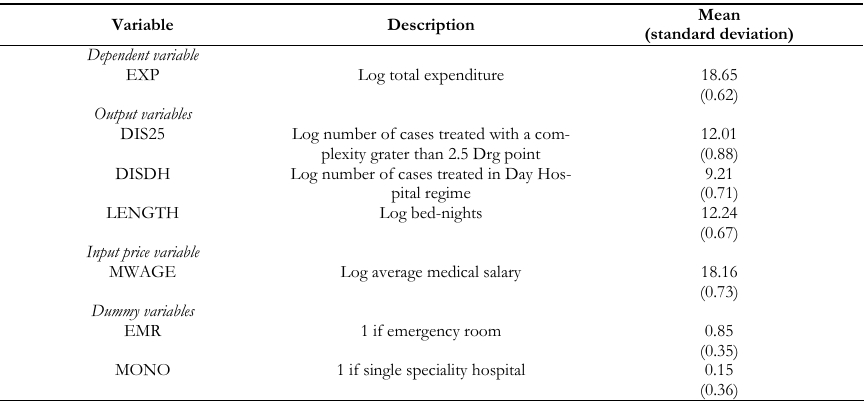
Descriptive statistics for Italian hospitals over the period